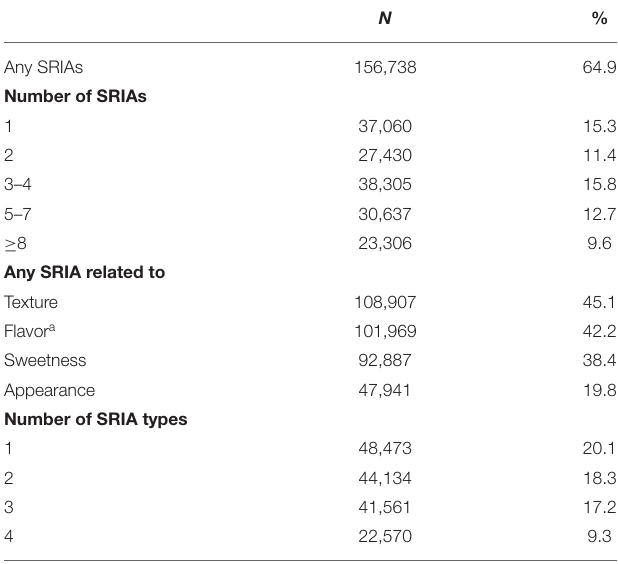
TABLE 3 | Prevalence of sensory-related industrial additives (SRIA) and types of SRIA in food items in the Branded Food Products Database ( n =